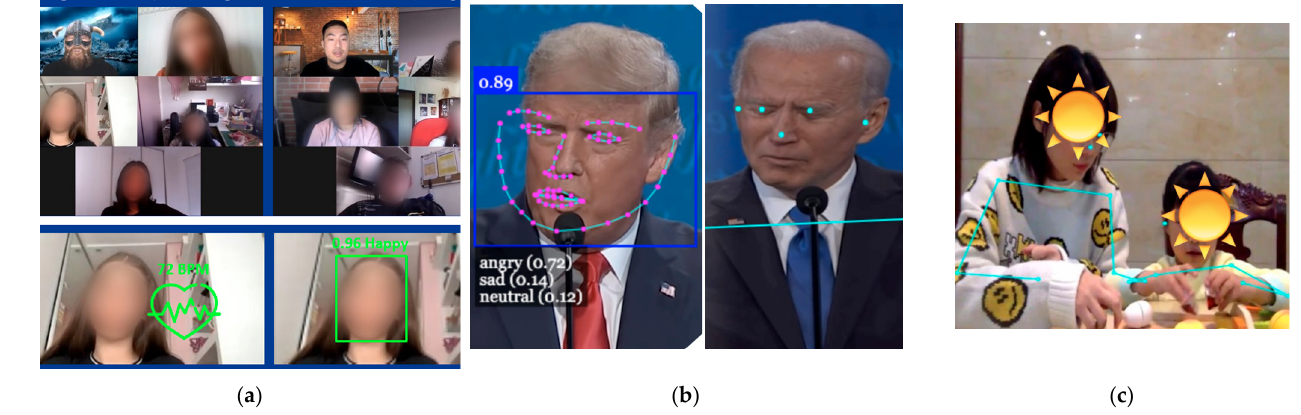
Figure 6. Examples of final projects (from left to right): ( a ) comparing the effect of augmented story-telling with normal storytelling on the audience’s heart rate and emotions; ( b ) analyzing facial expressions and body postures during presidential debates to compare moments where participants lied or told the truth; and ( c ) investing parents’ non-verbal interactive patterns while teaching math concepts to their children.